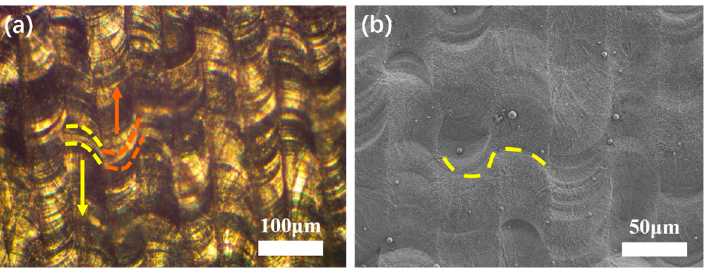
Figure 7. ( a ) Optical microscope image of the as-printed layer, ( b ) SEM image of the as-printed layer from top